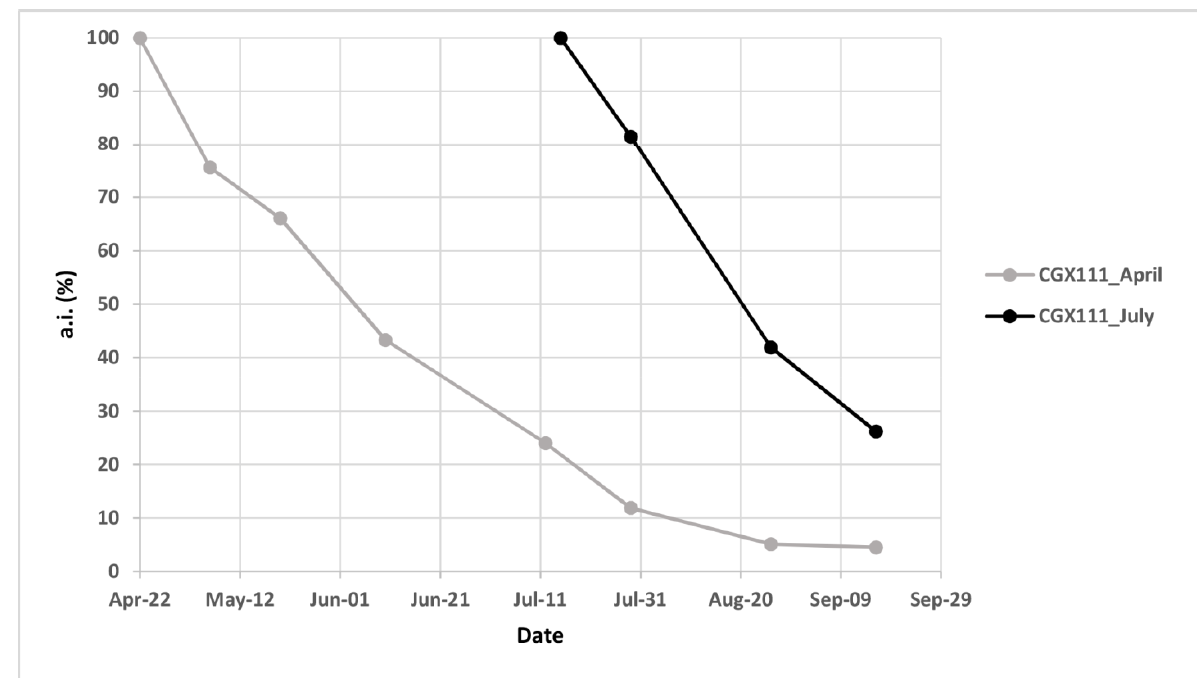
Figure 3. Cryptoblabes gnidiella pheromone load in the mating disruption dispensers applied in April or July, tested in Apulian vineyards during the 2016 growing season. a.i. = active ingredient.